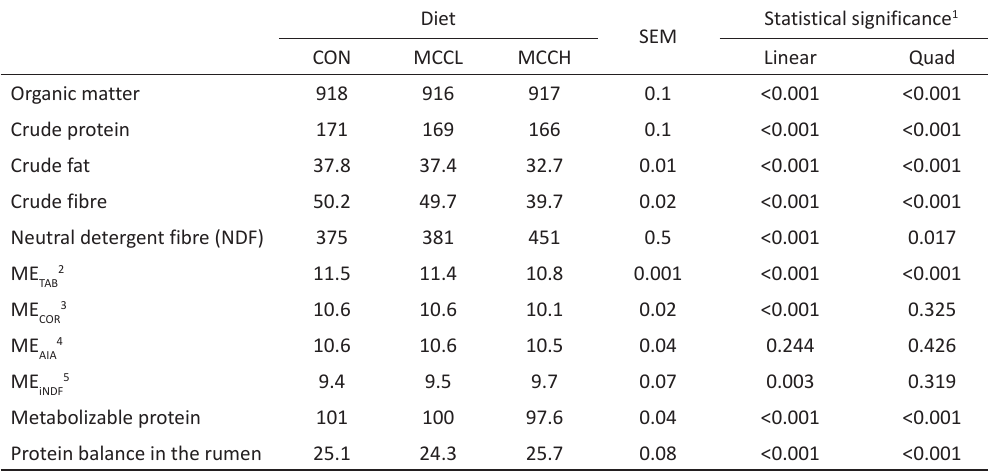
Table 3. Diet composition of dairy cows fed microcrystalline cellulose (MCC)